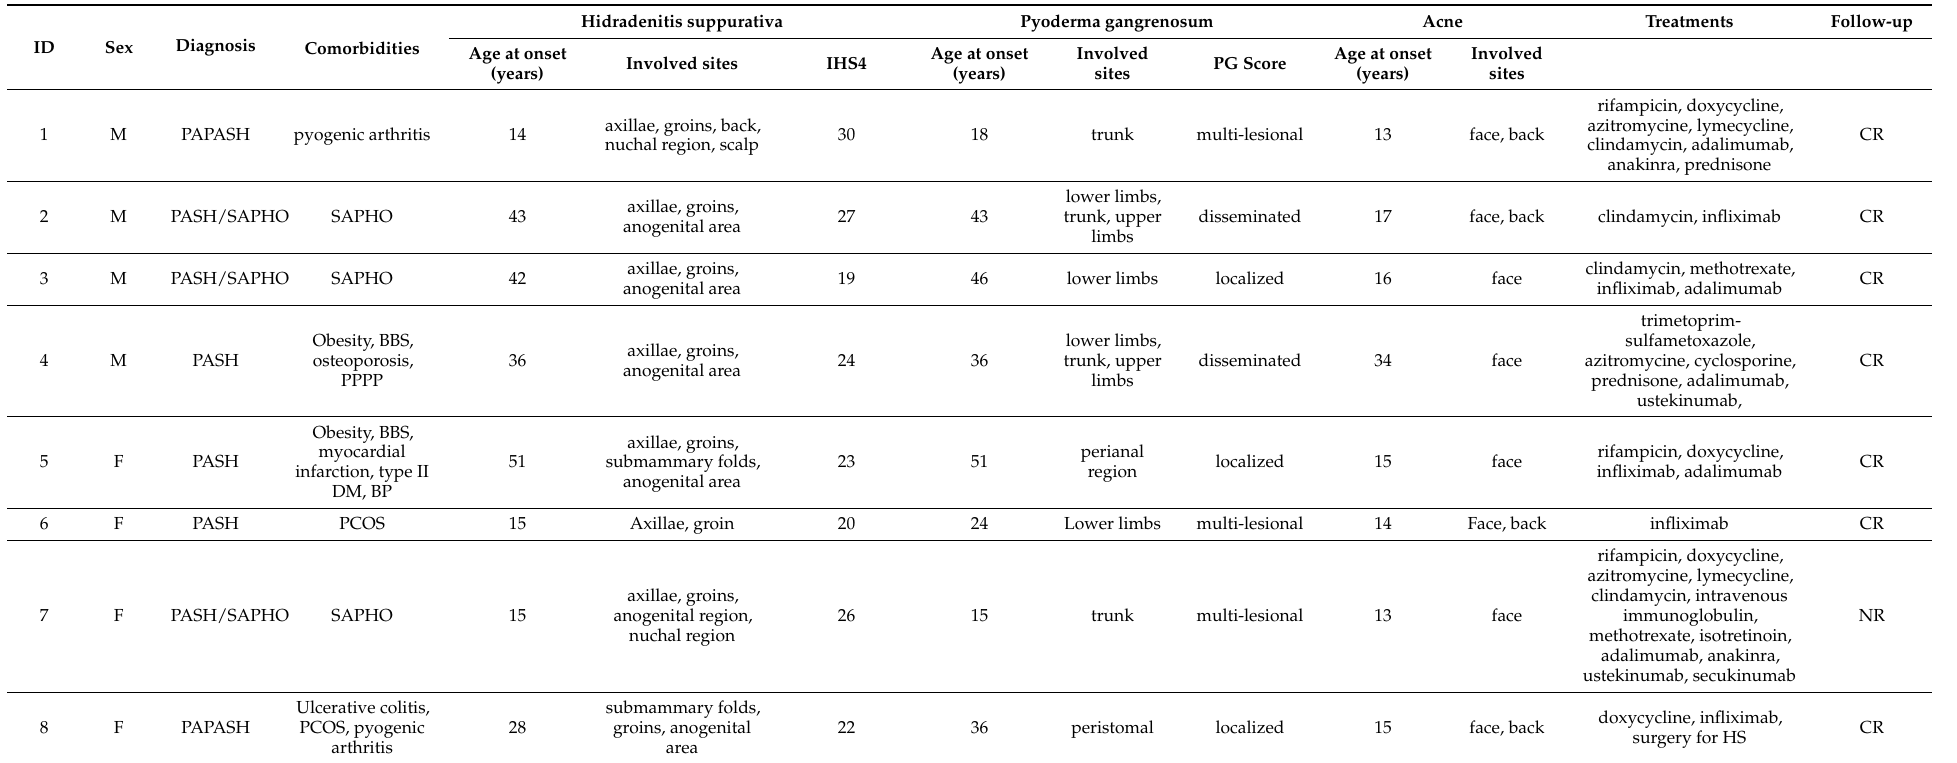
Table 1. Clinical features of patients with syndromic hidradenitis suppurativa. CR, complete response; PR, partial response; NR, no response; BBS, bowel